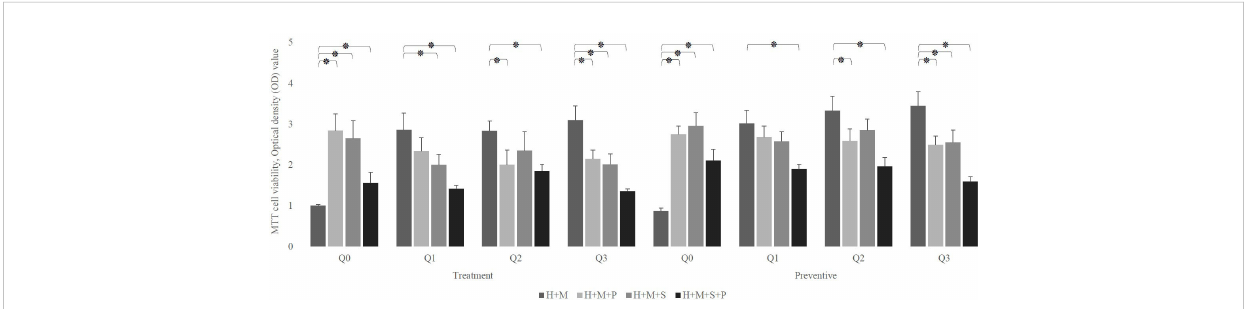
FIGURE 4 The effect of probiotics (P, L. plantarum ; S, L. salivarius ) on the viability of infected H (HEp-2 cell) treated with Q10 (Q0, absence Q10; Q1, 1 m g Q10; Q2, 5 m g Q10; and Q3, 10 m g Q10) in the treatment and preventive mode. The existence of probiotics in the absence of Q10 preserves the viability of HEp-2 cells compared to the absence of probiotics. On the other hand, the addition of probiotics to a Q10-contained environment decreases the infected HEp-2 cells ’ viability, regardless of setting, except for the coexistence of 1 m g Q10 with L. plantarum and 5 m g Q10 with L. salivarius in both settings and prevention with 1 m g Q10 with L. salivarius. The values are the mean ± SD of these assays. Asterisk (*) indicates a signi fi cant difference (p-value<0.05) in the values when compared to the control.